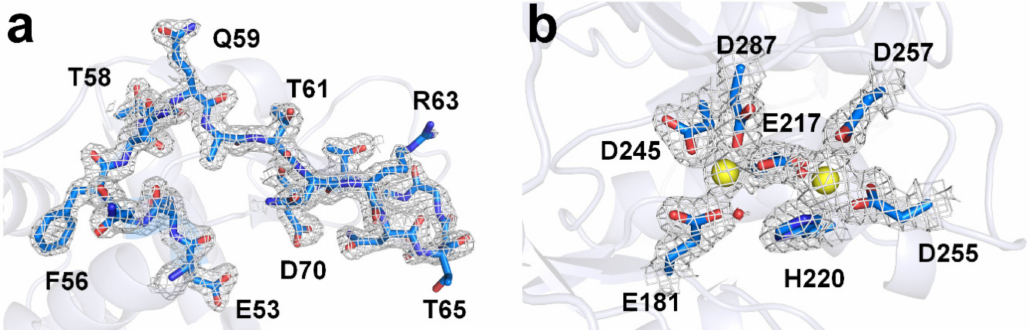
Figure 3. The 2Fo-Fc electron density map (grey mesh, 1.5 σ ) of the room temperature structure of ( a ) lysozyme and ( b ) glucose isomerase delivered in lard. Blue sticks represent amino acids around active sites, while yellow spheres represent metal ions at the active site of glucose